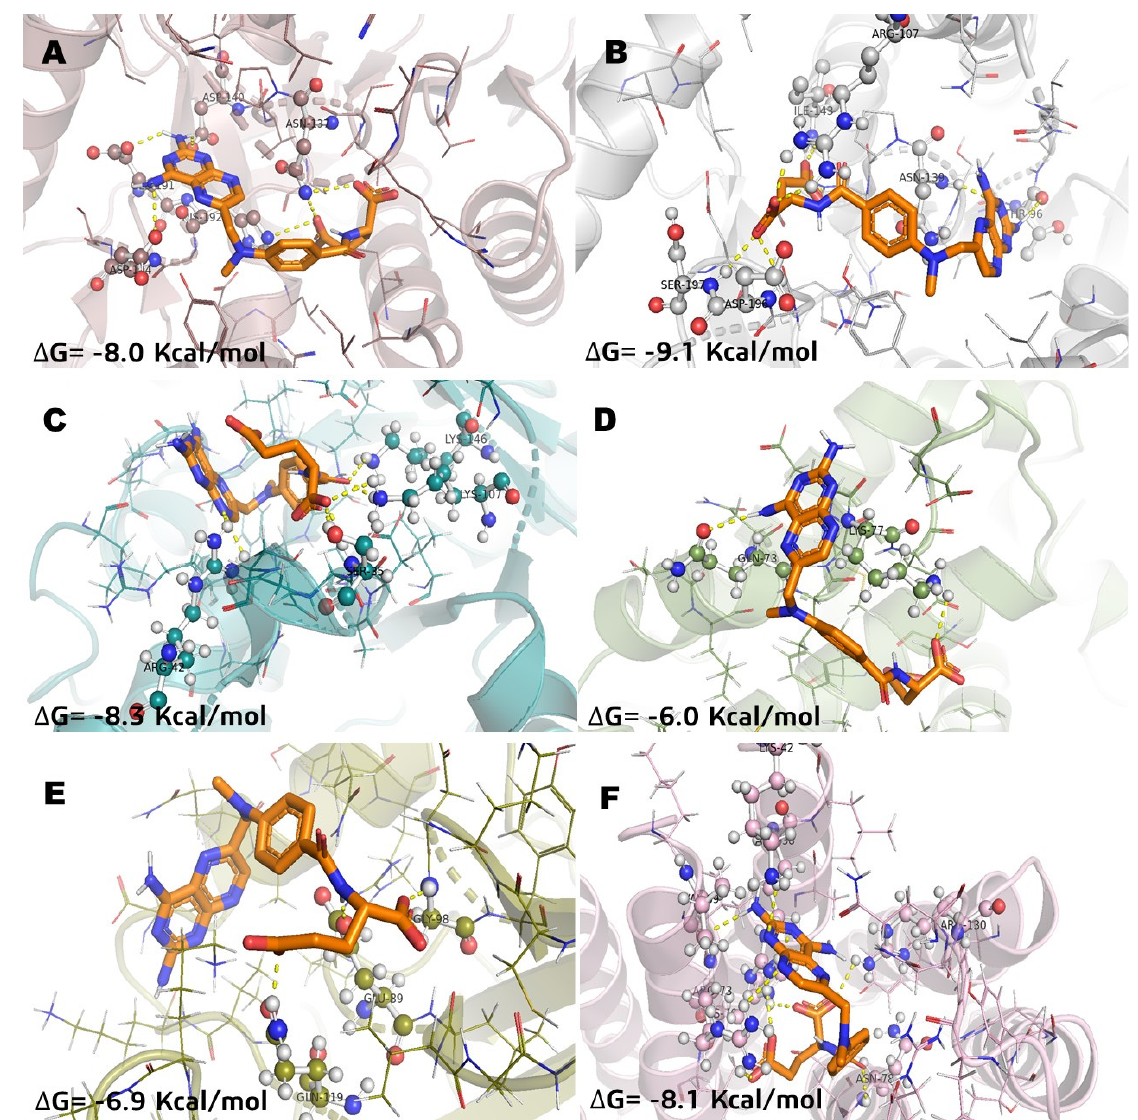
Figure 4. Molecular model of virtual screening for methotrexate ( MTX ) bound to ( A ) L-lactate dehydrogease A chain (LHDA), ( B ) L-lactate dehydrogenase B chain (LDHB), ( C ) Fructose-bisphosphate aldolase (ALDOA), ( D ) Bcl-2-regulator protein A1 (BCL-2A1), ( E ) NF-kappa B p65 (RelA) homodimer (NFkB), and ( F ) Microsomal glutathione S-transferase 1 (MGST1); Δ G = binding energy.